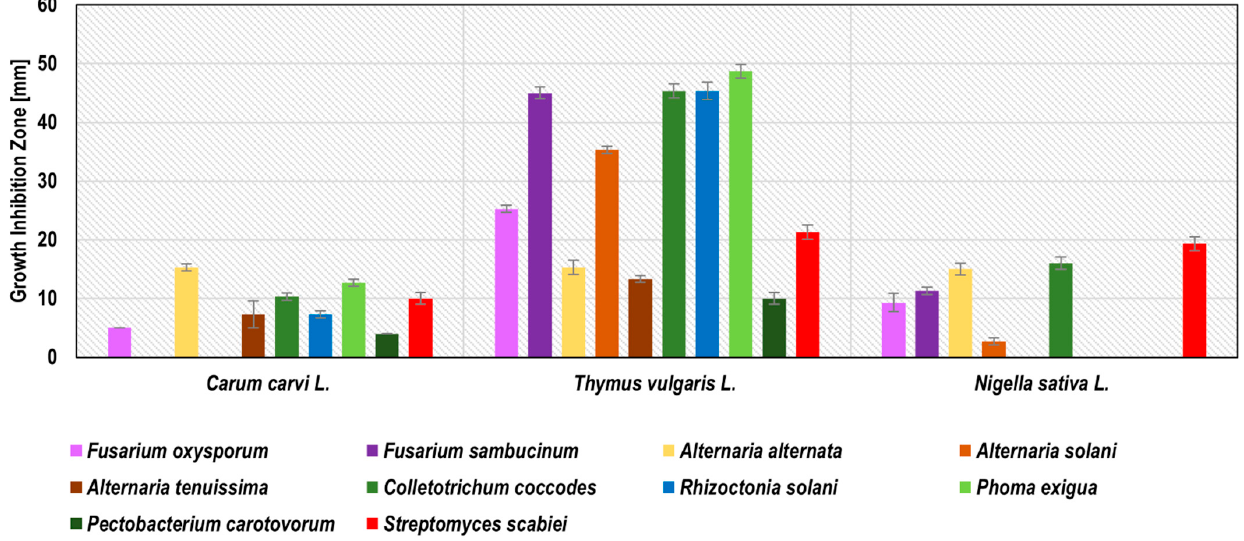
Figure 3. Activity of plant subcritical carbon dioxide extracts (SCDE) extracts against potato seed phytopathogens measured as growth inhibition zones in the agar-disc diffusion method. Glycol-water extracts exhibited in general a wider spectrum of activity against the potato phytopathogens than water extracts. The exceptions were garlic and clove extracts, which inhibited a similar number of pathogens regardless of the solvent used. The greatest